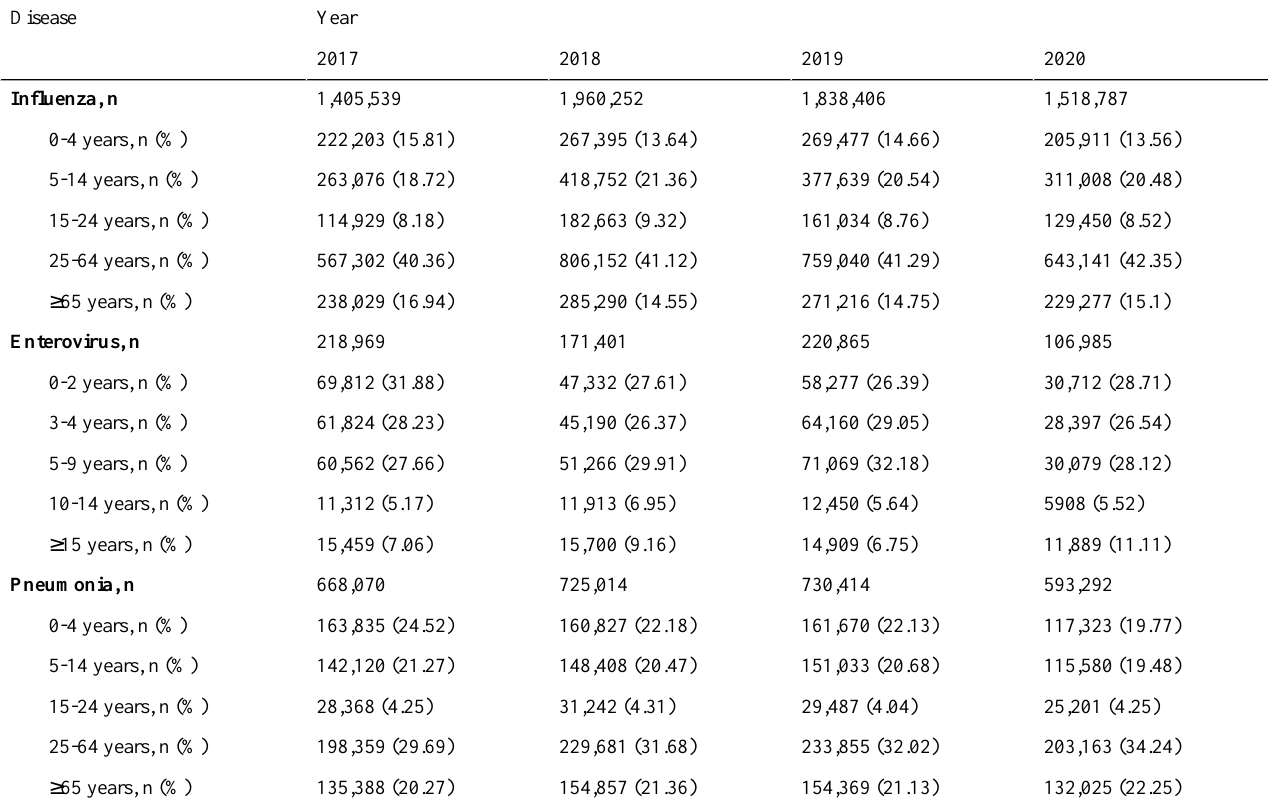
Table 1. Age distribution of people with respiratory viral infection during the study period (week 45 to week 21 of the next year).